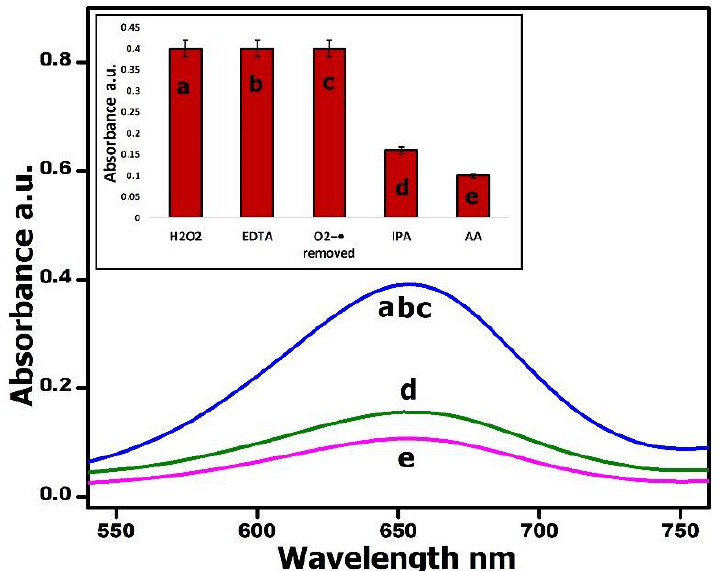
Figure 13. UV spectrum of different scavengers: a) H 2 O 2 b) EDTA c) O 2 − d) IPA e) AA added to the Zr-GO + H 2 O 2 + TMB reaction system. Inset shows the corresponding absorbance response. Error bars show the standard deviation from three parallel measurements.